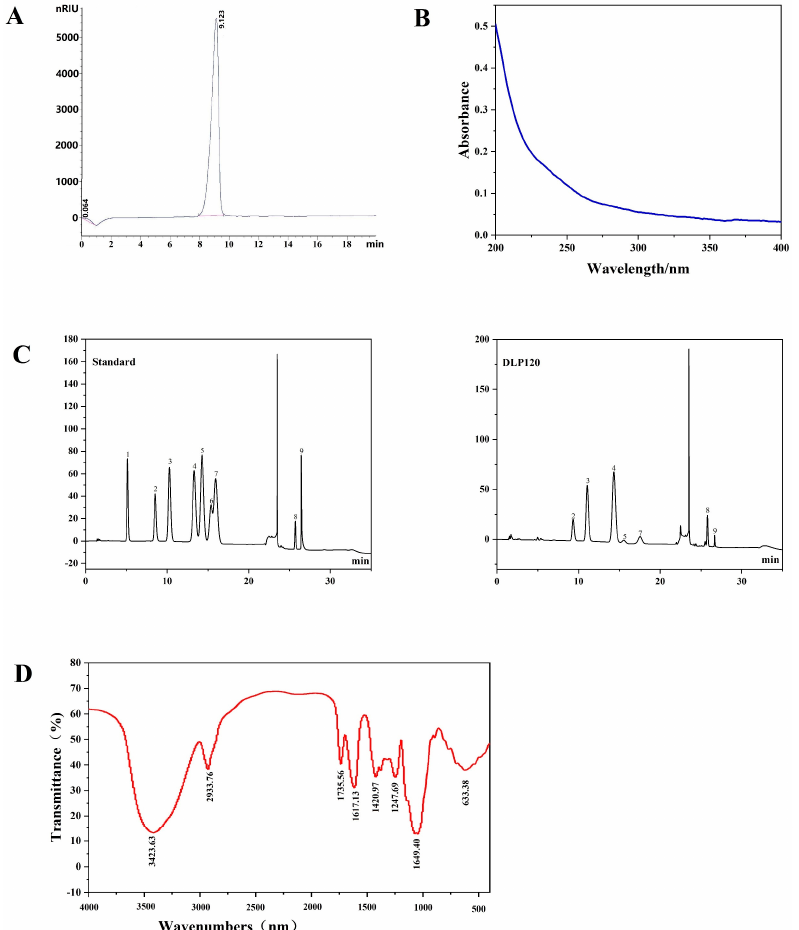
Figure 1. ( A ) The HPLC spectrum of DLP120. ( B ) UV spectrum of DLP120. ( C ) IC of the standard monosaccharides and the monosaccharides derived from DLP120: (1) fucose; (2) rhamnose; (3) arabinose; (4) galactose; (5) glucose; (6) xylose; (7) mannose; (8) galacturonic acid; (9) glucuronic acid. ( D ) FT-IR spectrum (in KBr) of DLP120.